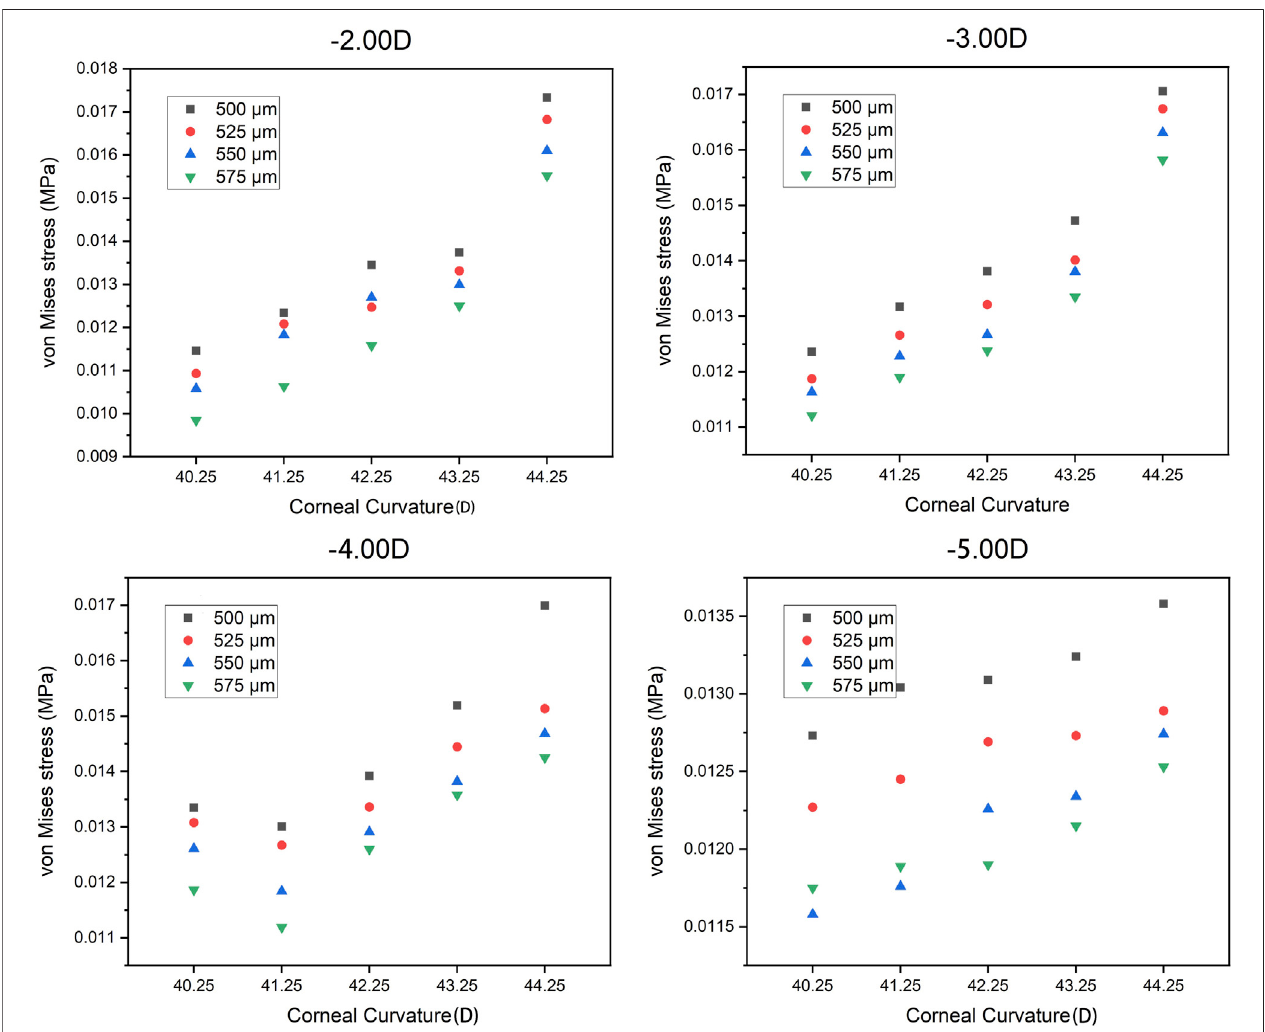
FIGURE 5 | Representative maximum von Mises stress in the peripheral corneal